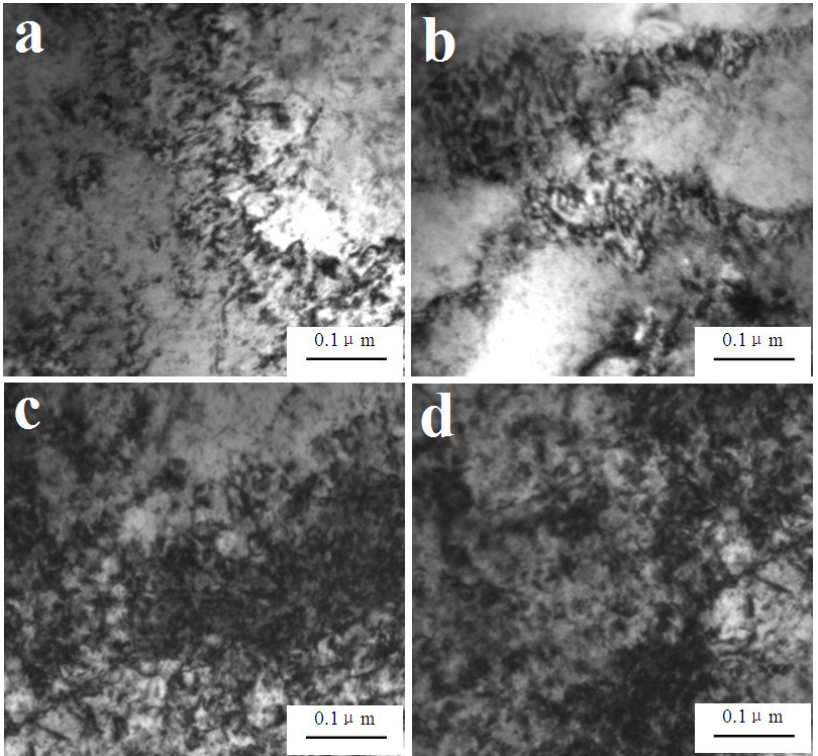
Figure 1. Dislocations in the matrix of W f /Cu 82 Al 10 Fe 4 Ni 4 composites after dynamic compression at 20 °C: ( a , b ) 800 s −1 and ( c , d ) 1600 s −1 .